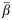
Crosstalk selectivity in the CLASH interactome.(a) Inverse of incoming and (b) outgoing selectivities as functions of β¯ for varying degrees of TH (different curves in the same panel) and BH (reported by the 3-state gauge in different panels). Curves are averaged over 100 independent realizations of transcription rate profiles.